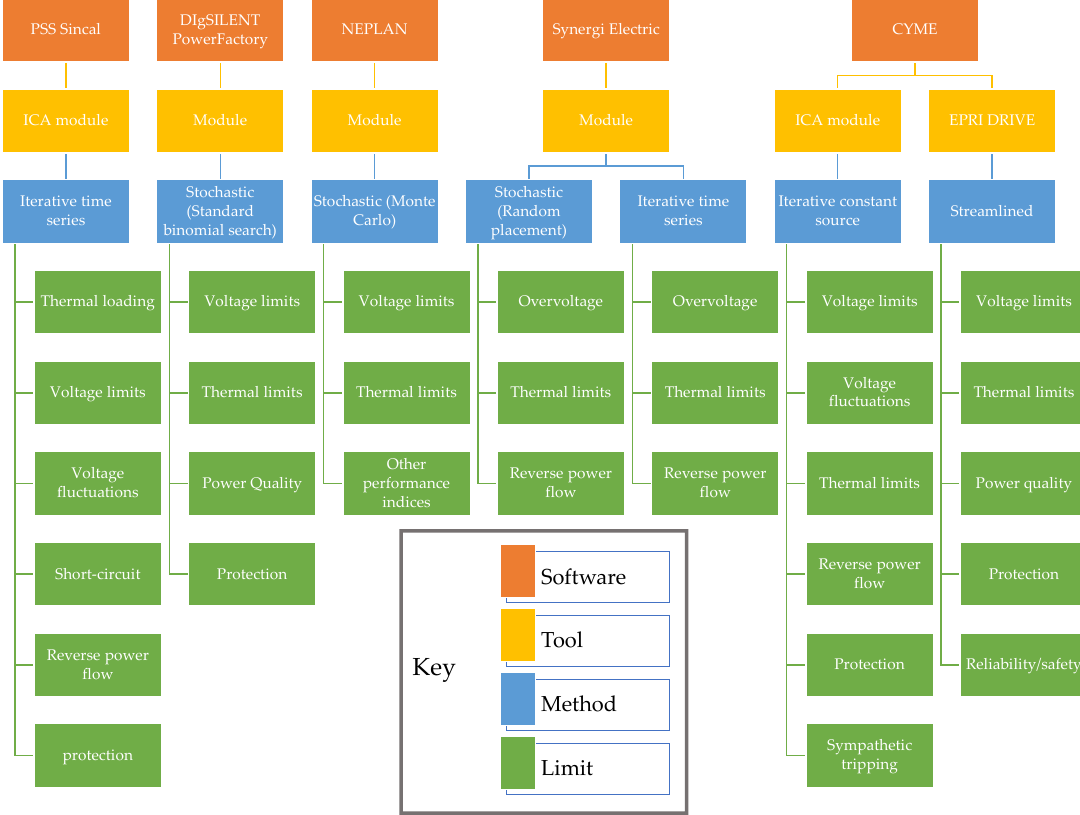
Figure 4. Highlights of the HC calculations tools.